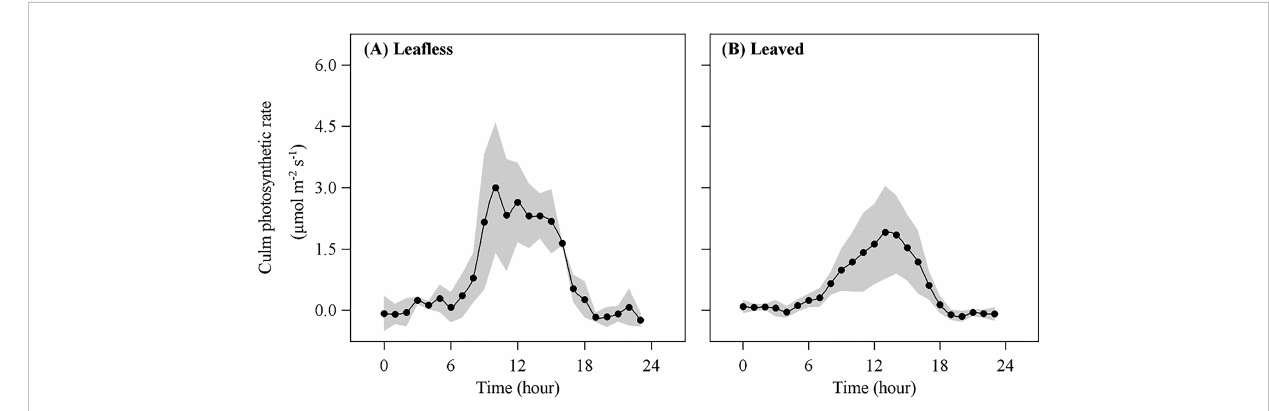
FIGURE 5 Culm photosynthetic rate ( E p ) in lea fl ess (A) and leaved (B) stages of the newly sprouted culms.